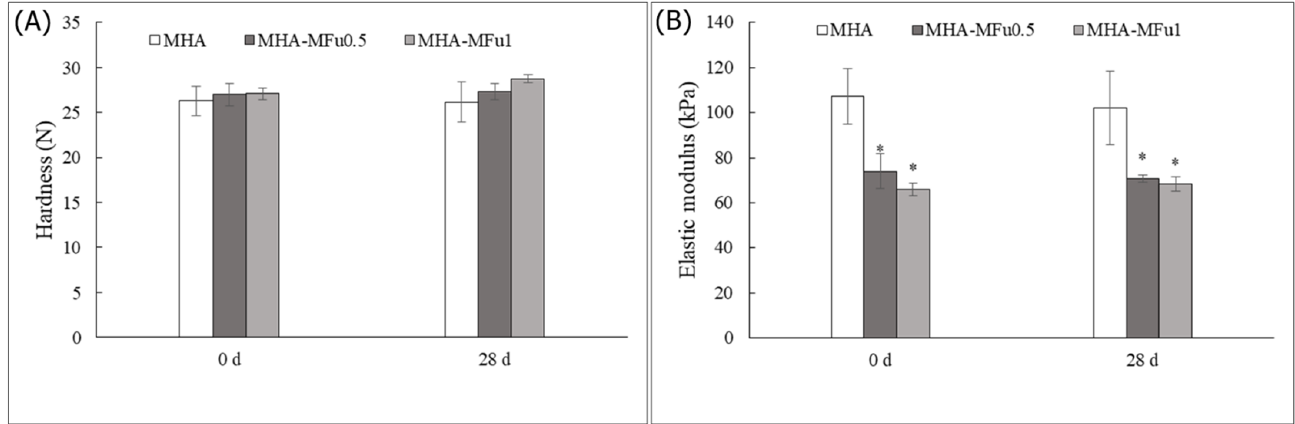
Figure 4. The mechanical properties of the MHA and MHA-MFu hydrogels: ( A ) hardness and ( B ) elastic modulus after 28 days. * ( p < 0.05) indicates the level of significance compared with MHA.